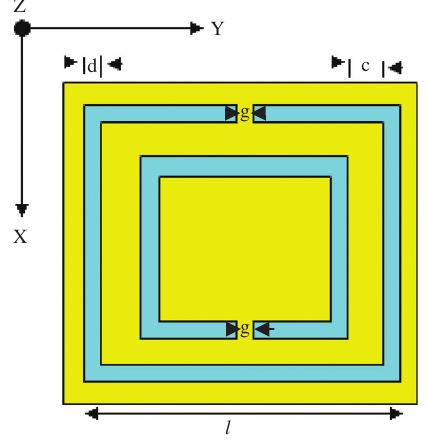
Figure 2 Structure of the SSRRs used in SAR